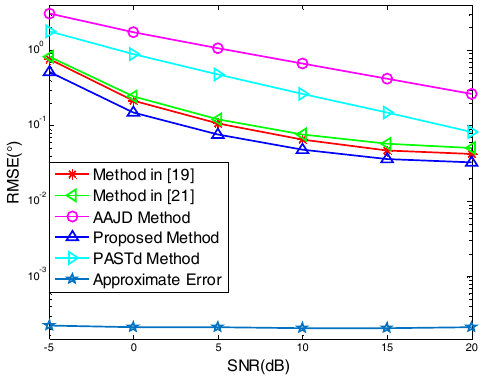
Figure 5. RMSE changes with signal-to-noise ratio (SNR).